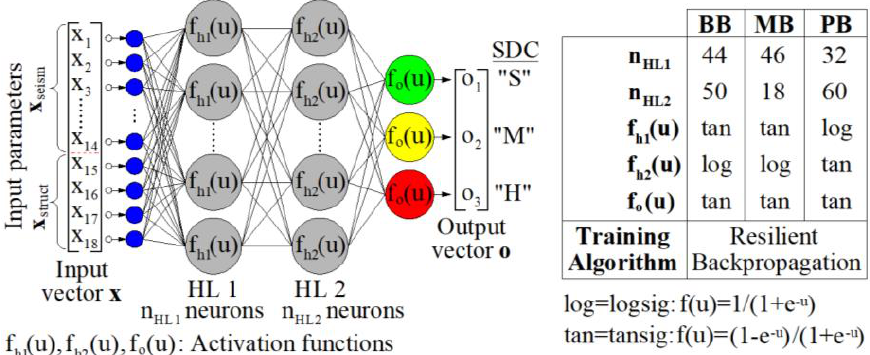
Table 2. The seismic parameters of the input vectors for the trained MFPNNs of the developed soft- ware.